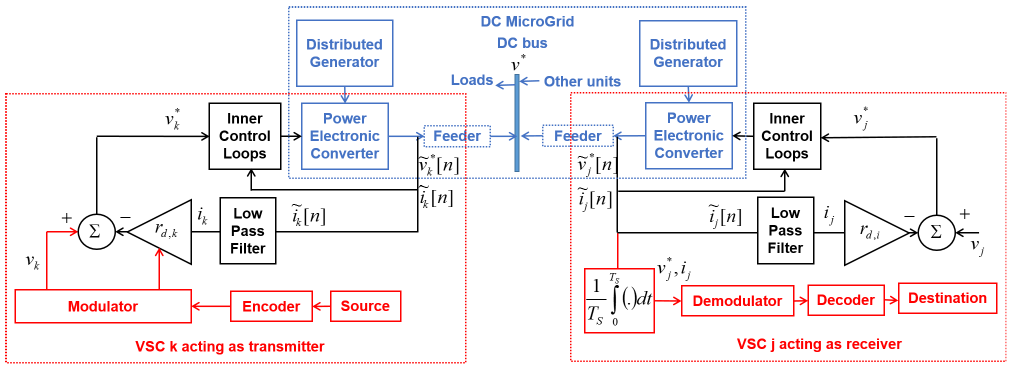
Figure 3. Power talk: the MG as the communication